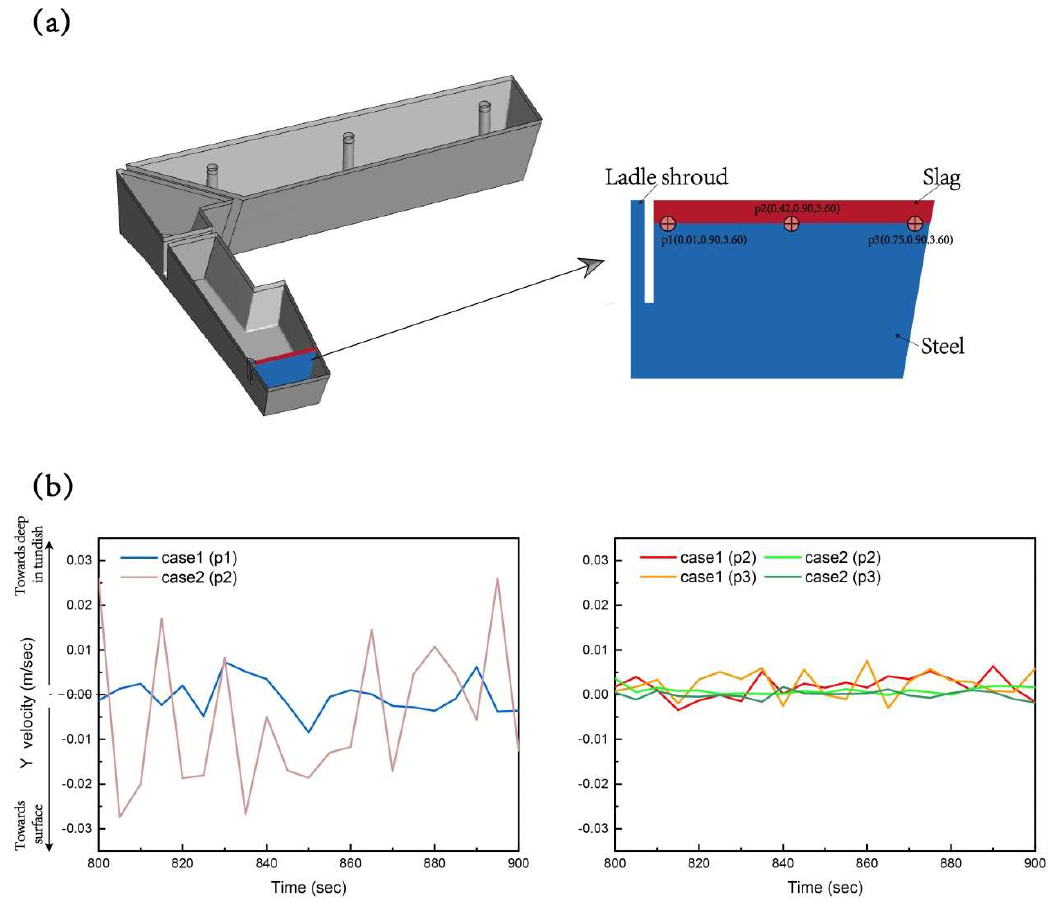
Figure 9. ( a ) Points’ location for fetching the correlated signals; ( b ) wave height of point p1, point p2 and point p3 in 800–900 s.